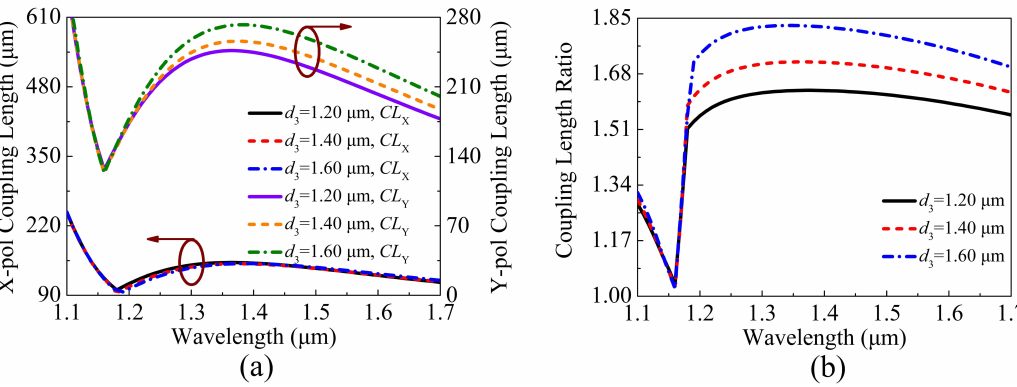
Figure 7. The variations of the ( a ) CL X , CL Y , and ( b ) CLR of the proposed V-DC-PCF PBS for different d 3 . Figure 9a,b show the variations of the CL X , CL Y , and CLR of the proposed V-DC-PCF PBS when t is chosen as 45, 55, and 65 nm, respectively. It can be seen from Figure 9a that as t increases, the CL X and CL Y increase at the short wavelength side and decrease at the long wavelength side. It can be seen from Figure 9b that as t increases, the CLR increases at the short wavelength side and decreases at the long wavelength side, and the position of the phase-matching wavelength gradually shifts towards the short wavelength side.